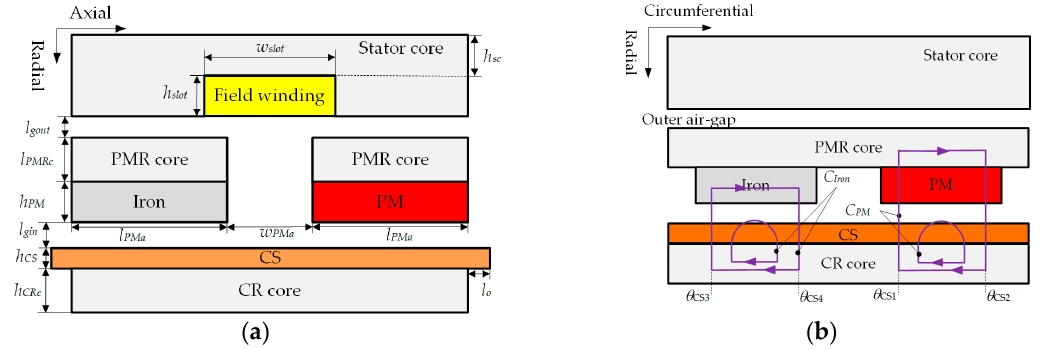
Figure 3. The 2D view of the HE-ASECC. ( a ) Axial section. ( b ) Axial cross section.